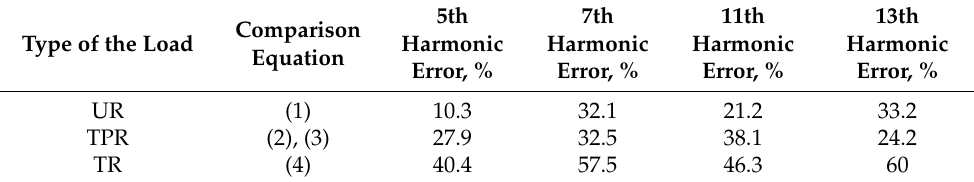
Table 3. Relative errors of the calculated and measured current harmonic magnitudes.